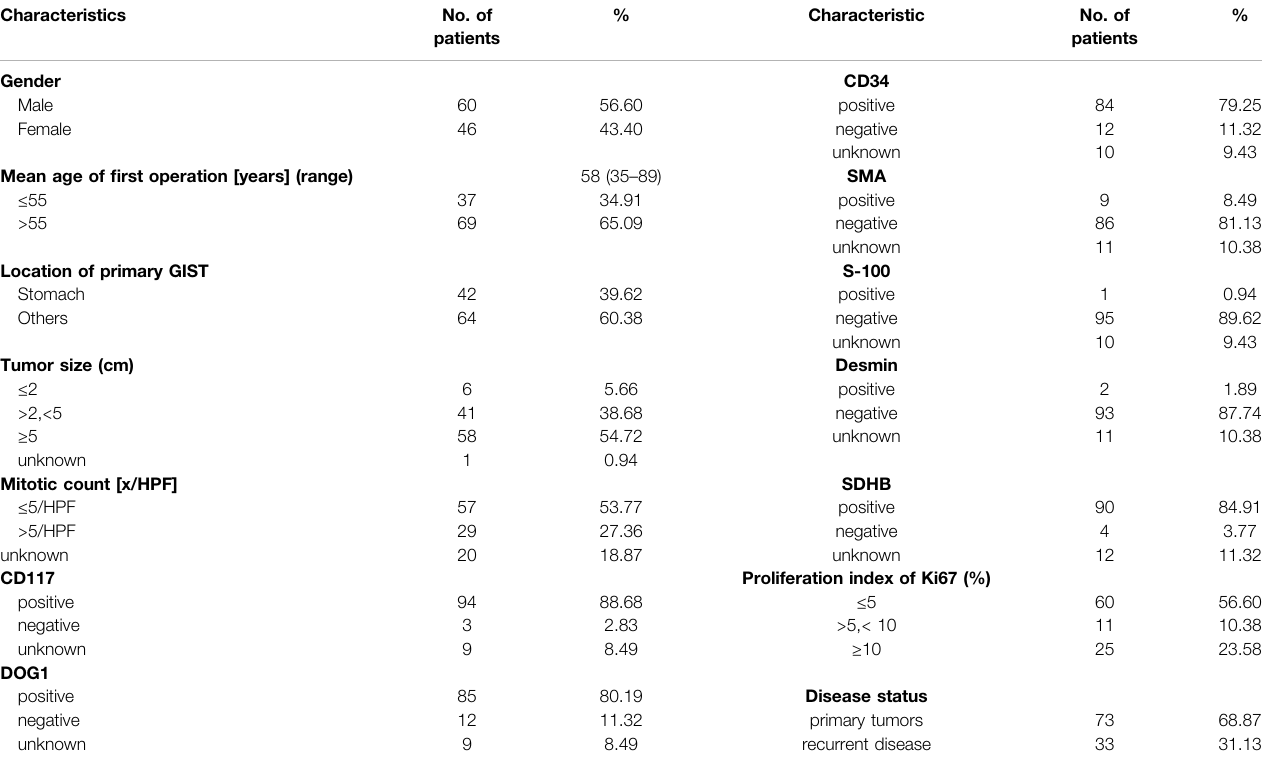
TABLE 1 | Demographic and clinical characteristics of 106 patients with GIST.